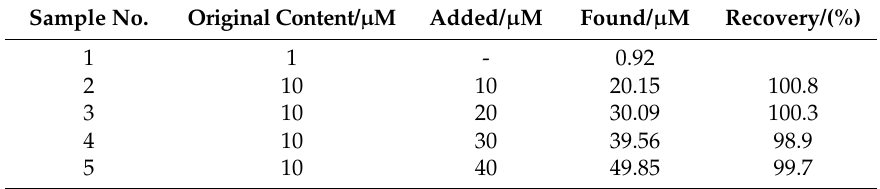
Table 4. Determination of cysteine in a dietary supplement with the electrode “ACS”, at pH 7 (90 mL 0.1 KNO 3 + 10 mL 0.1 M phosphate buffer), by using the standard addition method. Recovery was calculated based on the five